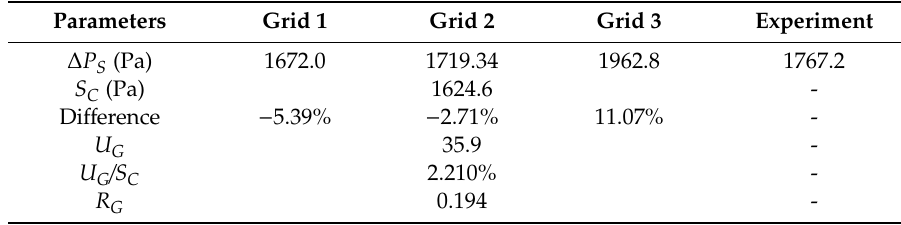
Table 8. The di ff erence between prediction and measurement of 1BF component of hull pressure fluctuation ∆ P S , grid uncertainty U G , and convergence ratio R G